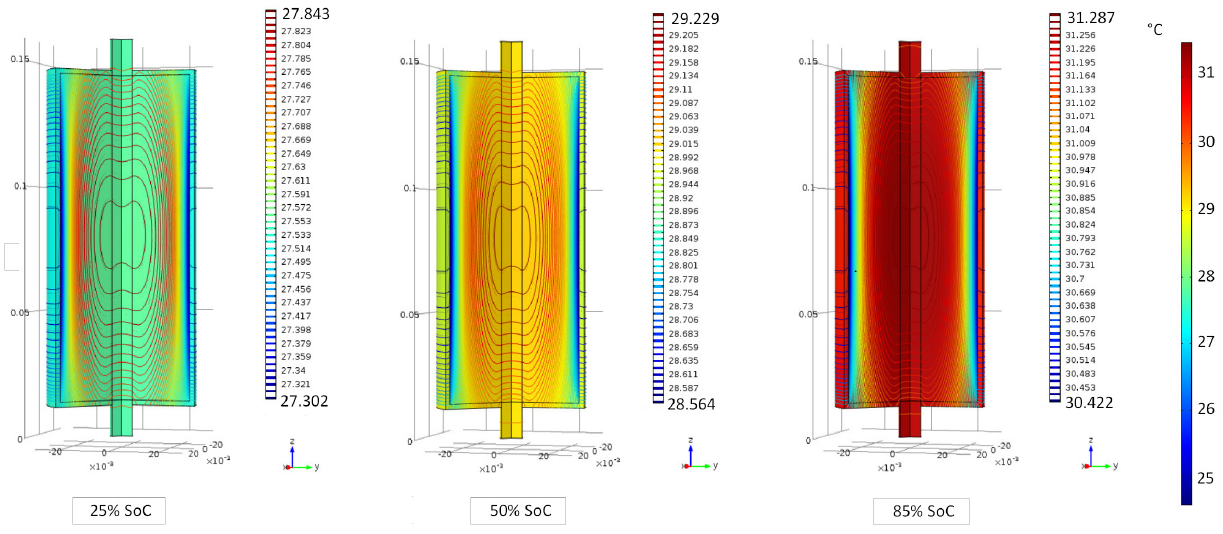
constant charge—Homogeneous t